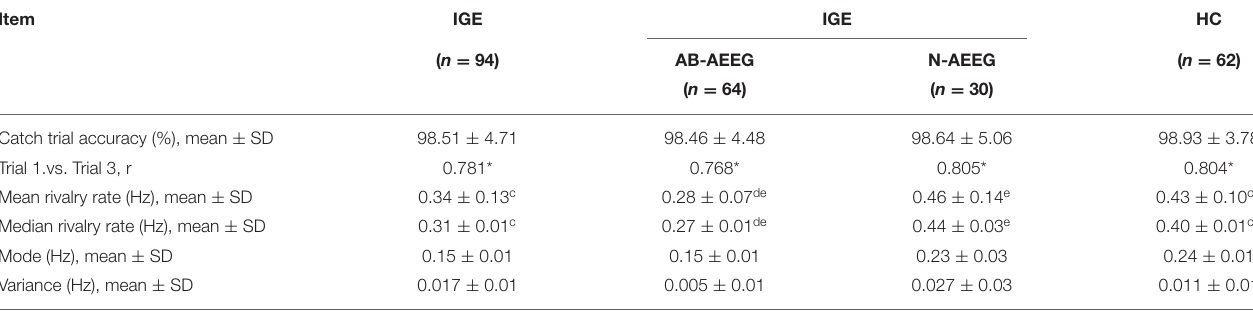
TABLE 2 | BR alternation rates of different IGE groups and subgroups.